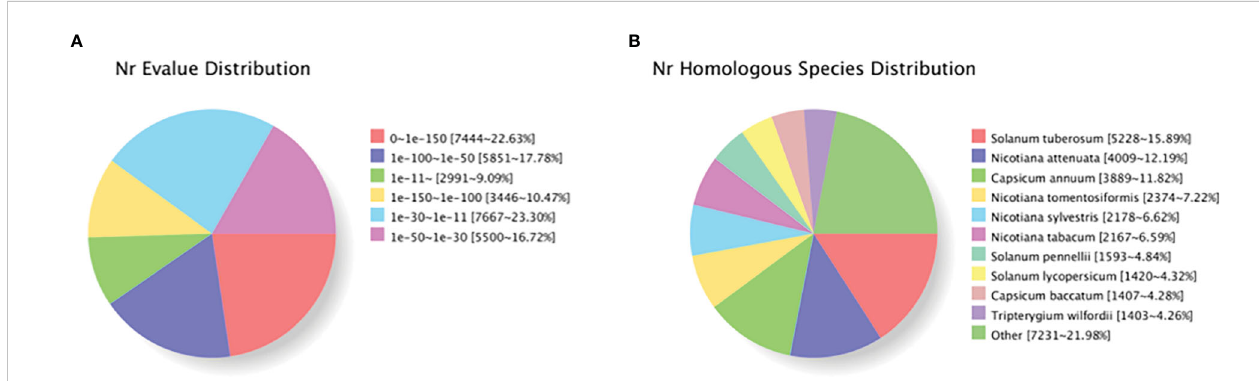
FIGURE 5 Characteristics of homology search of individual plants of Lycium barbarum L. using NCBI non-redundant (Nr) database. (A) Distribution of E-value for unique sequence blast hit with cutoff E-value of 1E − 5 . (B) Species distribution in each single-phase top BLAST with cutoff E-value of 1E − 5